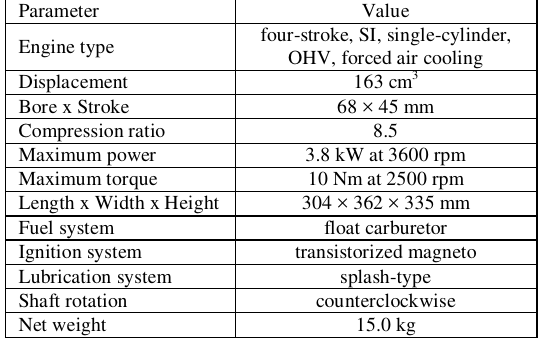
Table 1. Technical specifications of the engine used in the